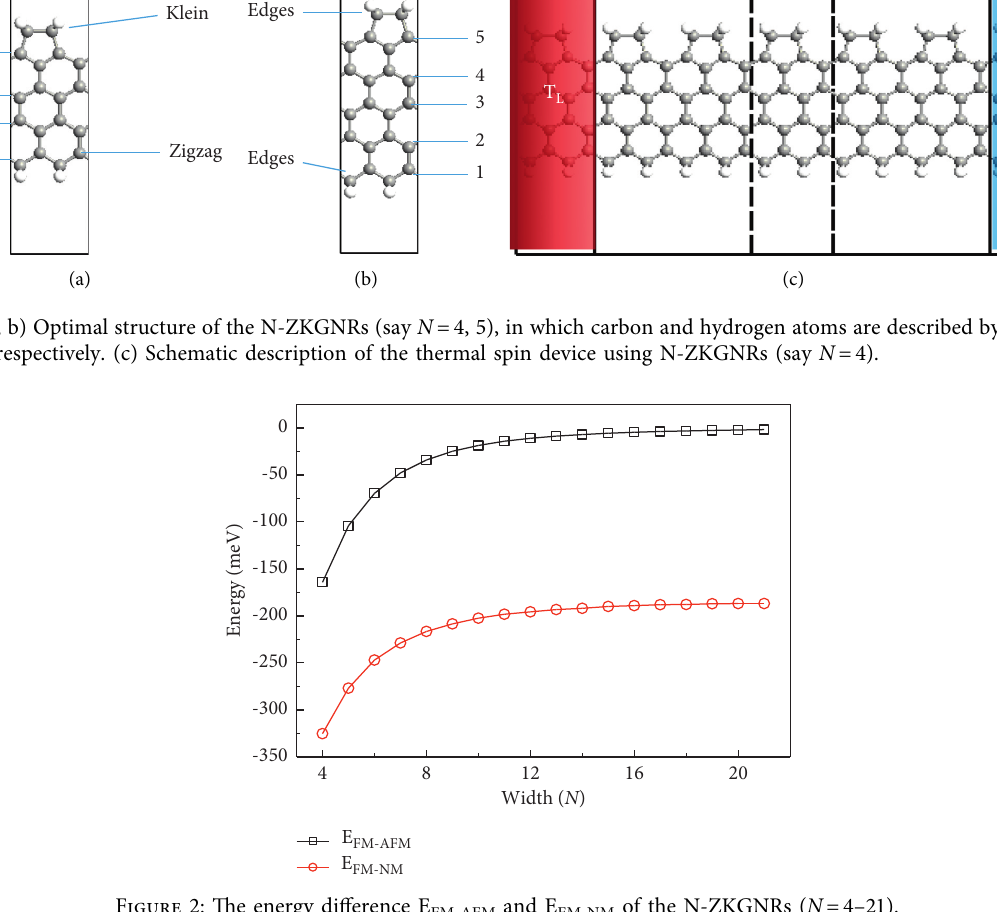
FM-AFM and E FM-NM of the N-ZKGNRs ( N